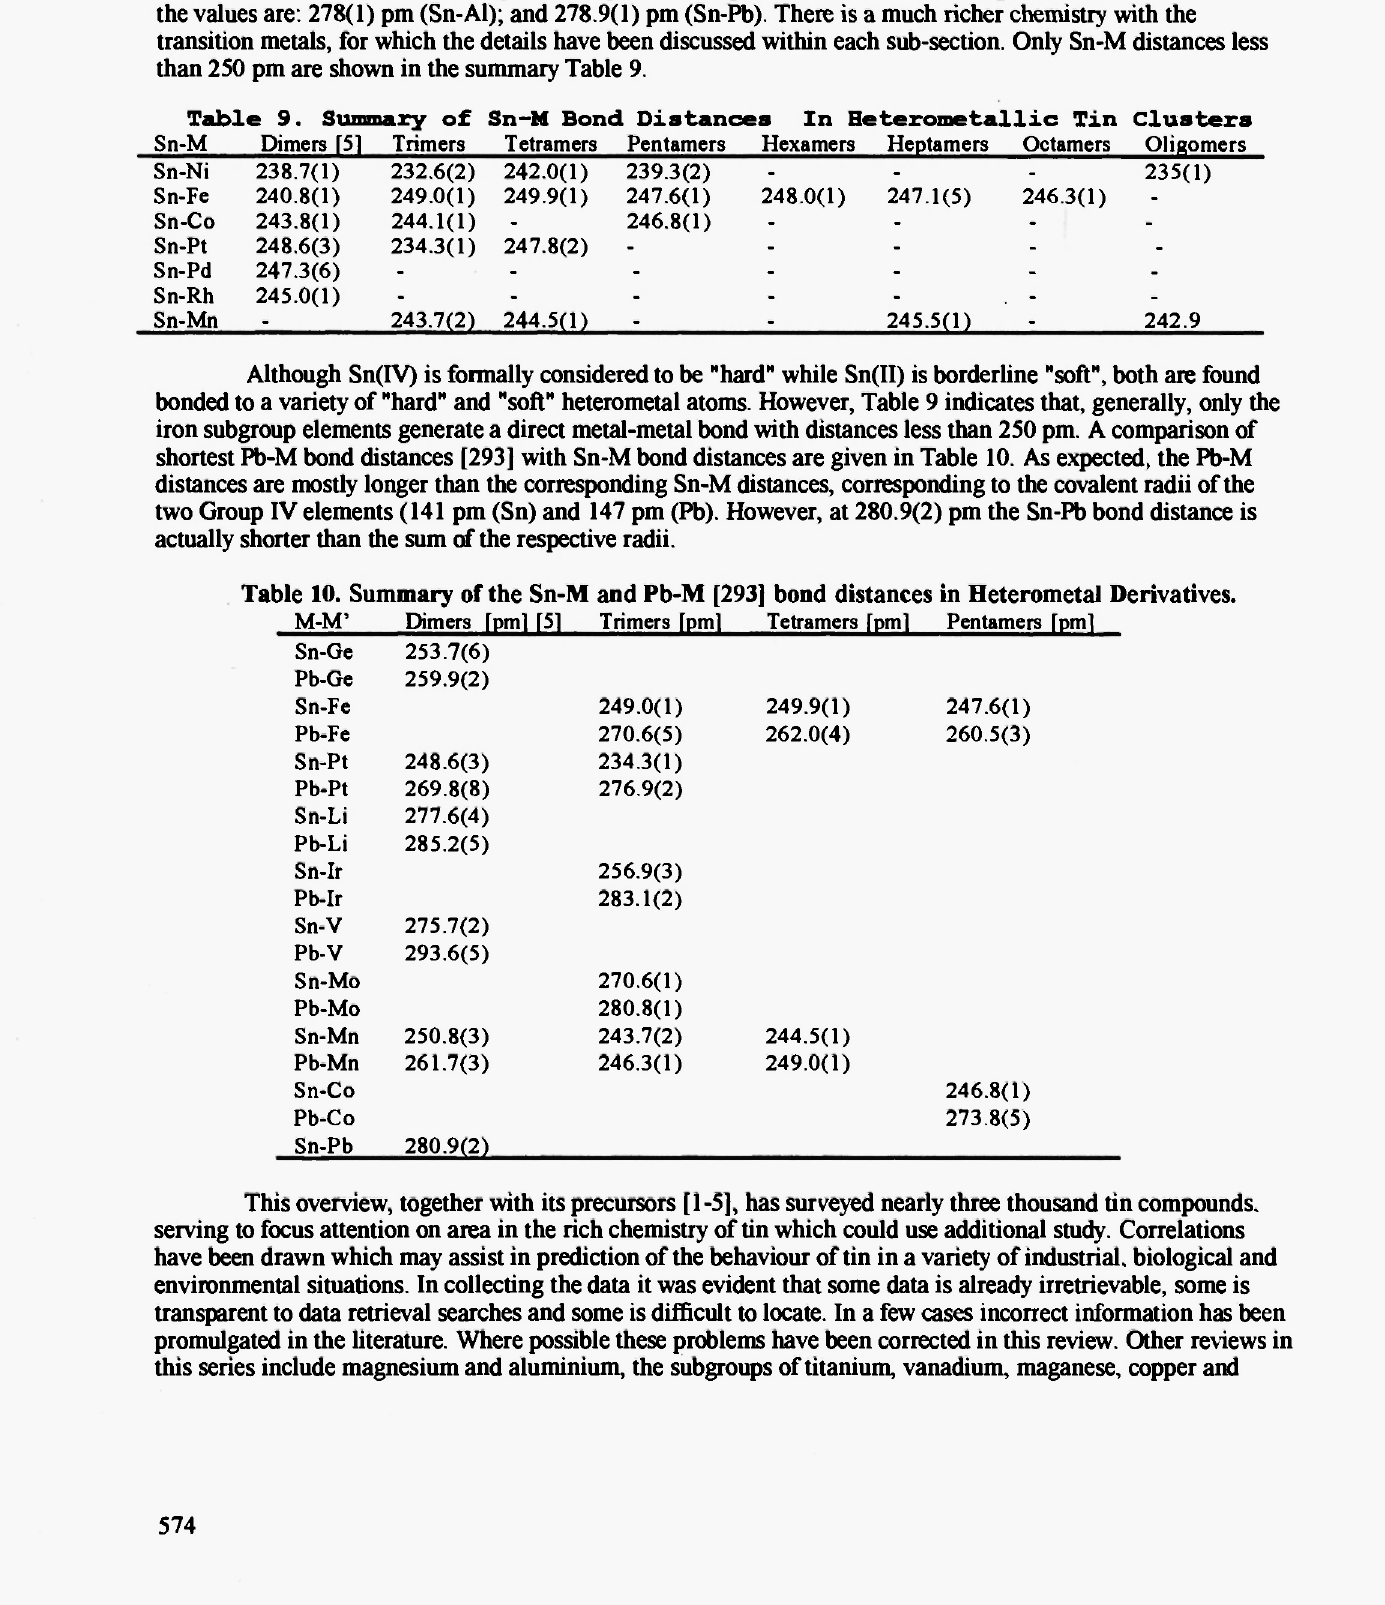
Table 9. Summary of Sn-M Bond Distances